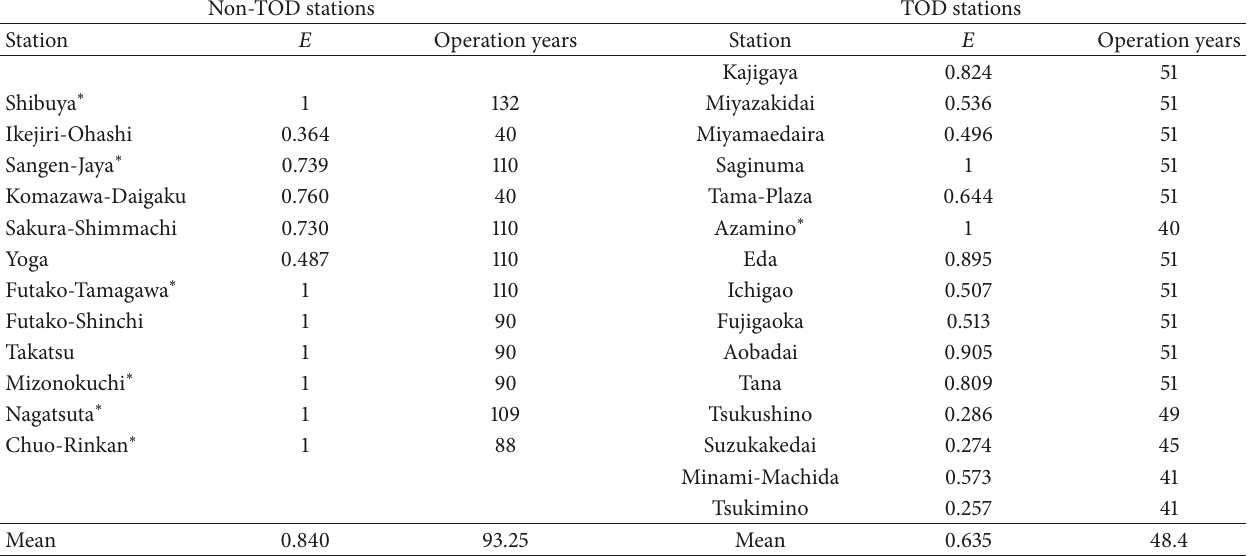
Table 3: Efficiency of each station.